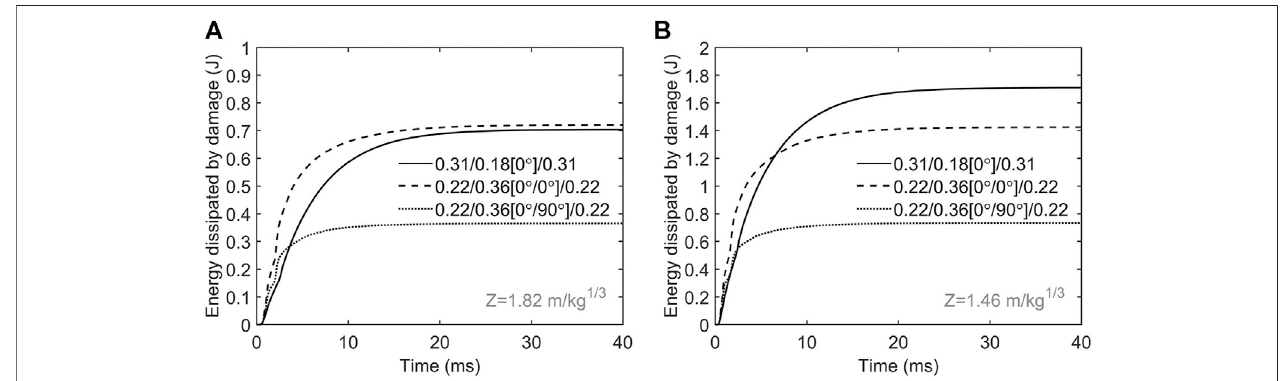
FIGURE 12 | Energy dissipated by damage with (A) the impulsive load of Z (cid:2) 1 . 82 m / kg 1 / 3 and (B) the impulsive load of Z (cid:2) 1 . 46 m / kg 1 / 3 .